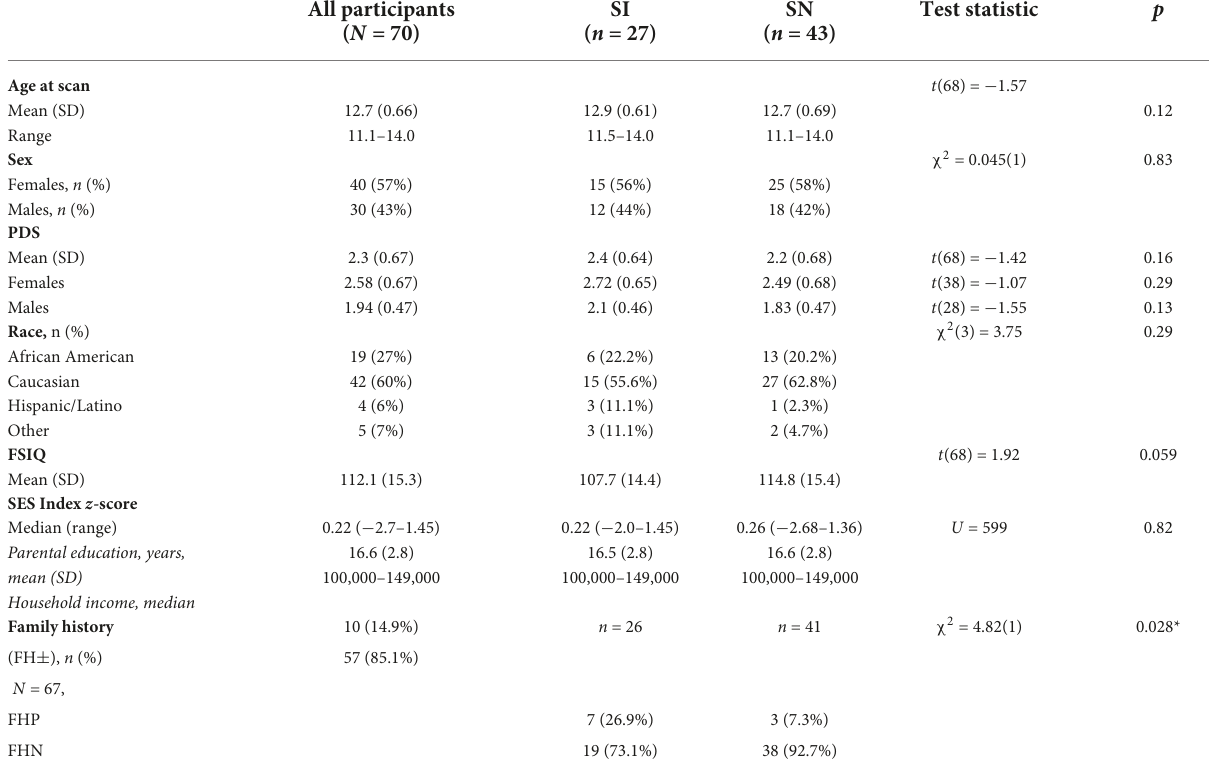
TABLE 1 Participant characteristics at “baseline”